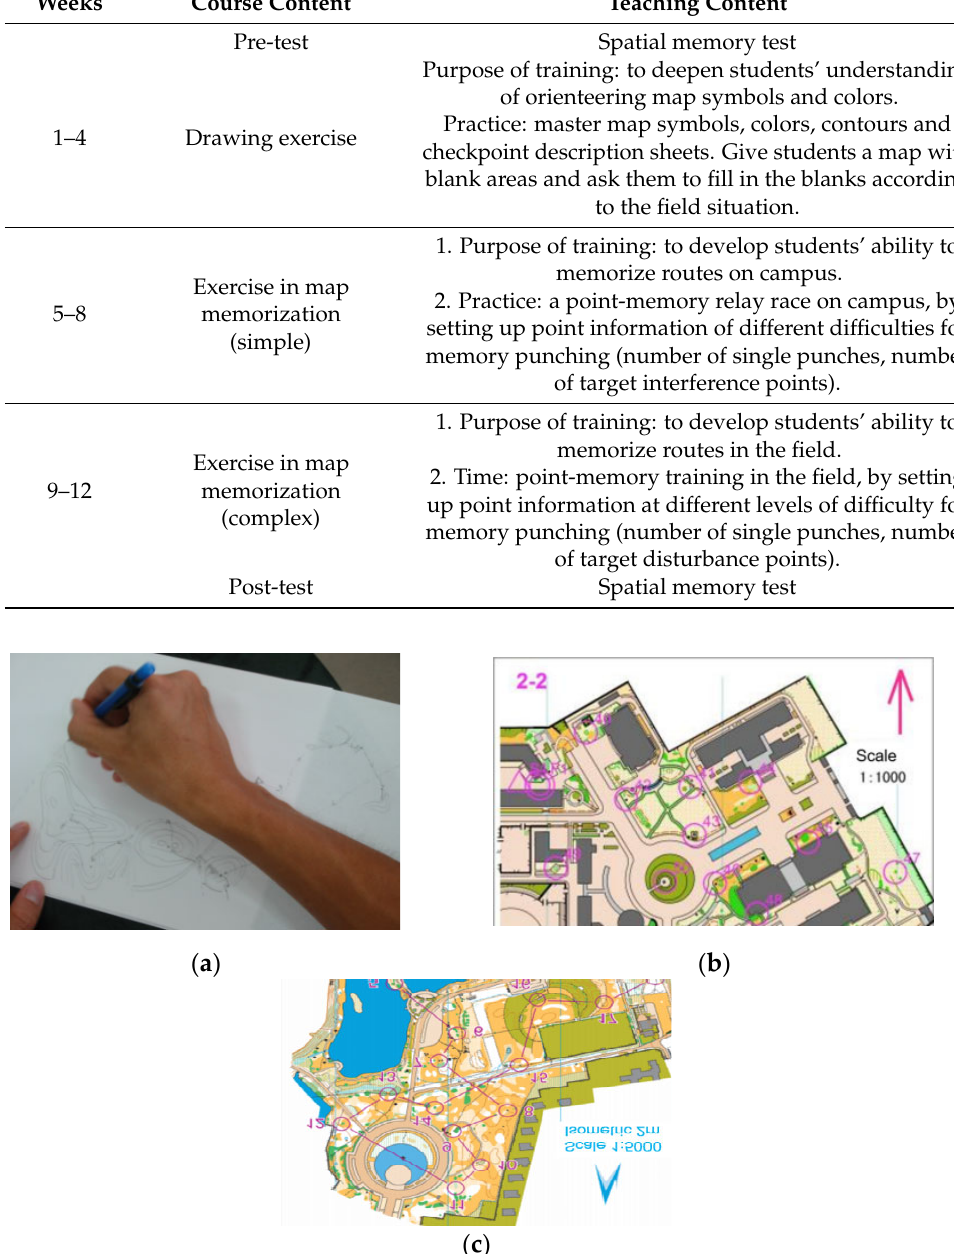
Figure 1. Spatial memory experimental material. ( a ) The purpose of the exercise is to make students proficient in basic information such as symbols, colors and checkpoint description tables in the map; ( b ) aim to improve students’ ability to memorize campus ‐ map route memory; ( c ) aim to improve students’ ability to memorize campus ‐ map route